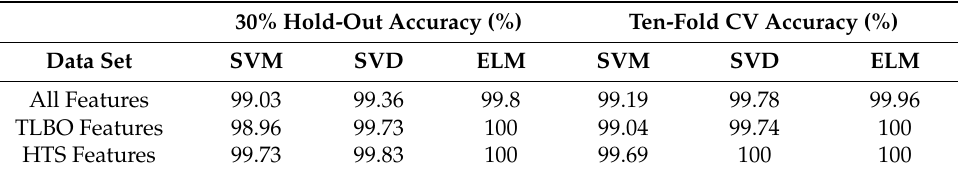
Figure 12. ( a – c ) Compound fault prediction: ( a ) SVM ( b ) SVD, and ( c ) ELM models with ten-fold CV. Table 5. Compound fault prediction